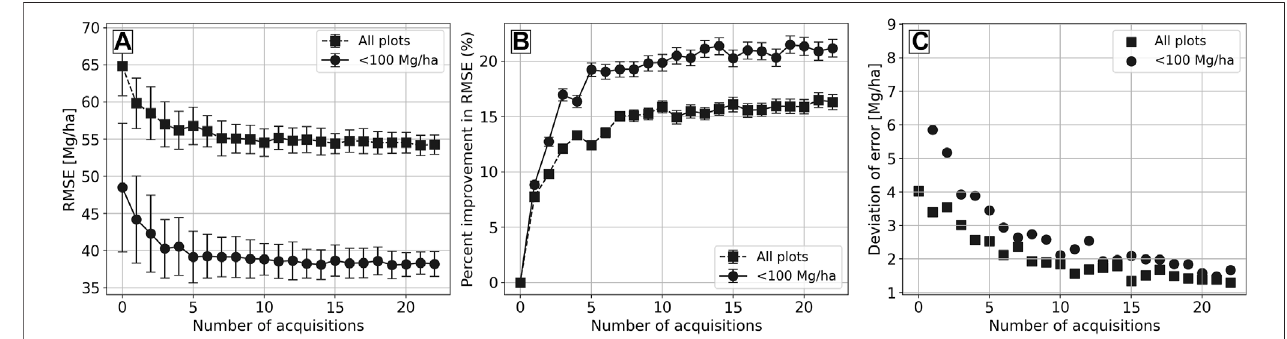
FIGURE 11 | (A) shows the RMSE of the WCM estimated AGB with respect to the GEDI measured AGB, and (B) shows saturation of the WCM curve for each ALOS-2/PALSAR-2 acquisition. The scatter plots in (C – I) compare the multitemporal AGB estimates using ALOS-2 data acquired each year with the GEDI measured AGB. The error bars along the abscissa represent the RMSE in the GEDI measured AGB, while the error bars along the ordinate represent the standard deviation of the AGB estimates for each year.